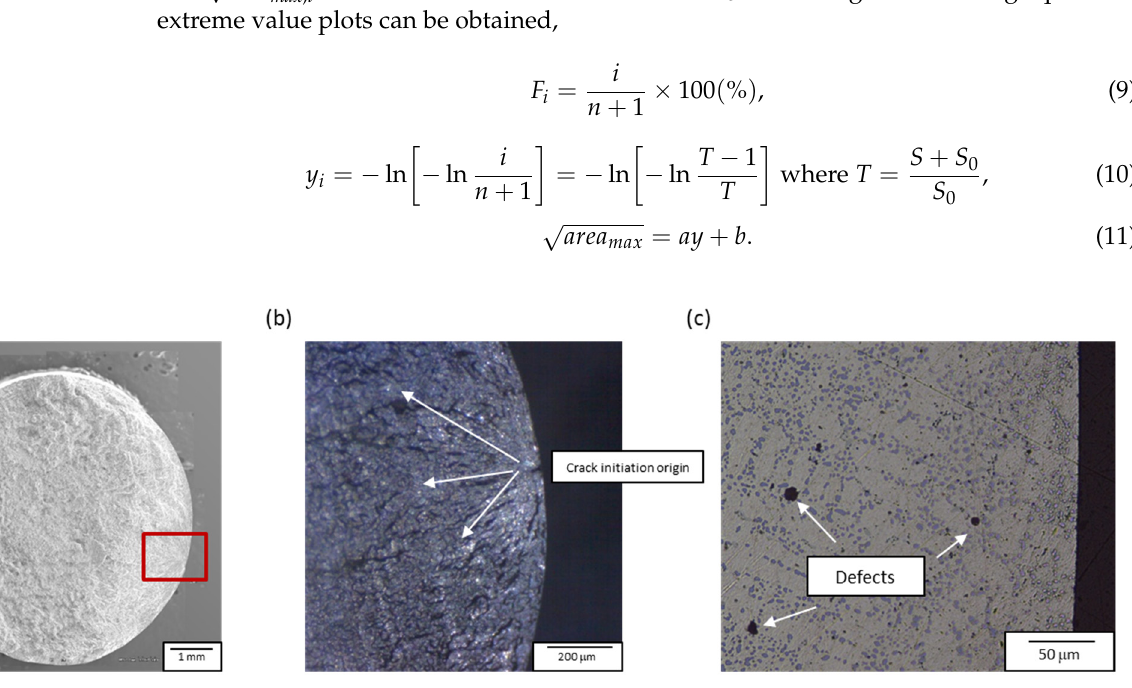
Figure 2. Observed surfaces of rotary bending specimens. ( a ) Scanning electron microscopy; ( b ) optical microscopy, Model S-4300 from Hitachi (Tokyo, Japan); and ( c ) mirror-polished surface.